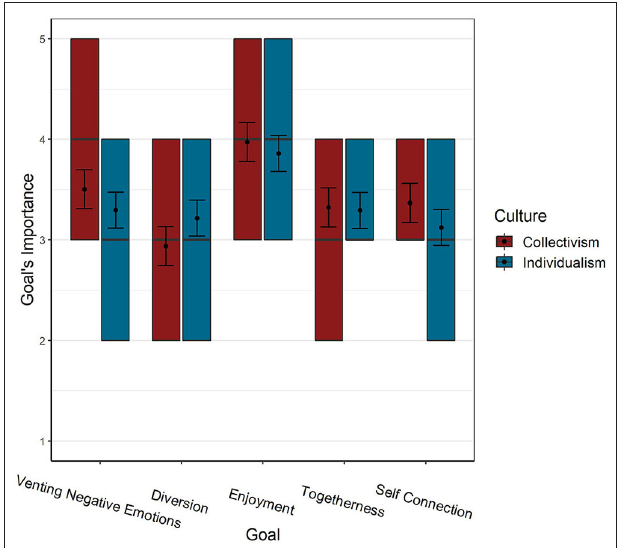
FIGURE 1 | Importance of goals as a function of culture. Error bars represent 95% CI. Colored squares represent the 2nd and 3rd quartiles of responses. Black lines represent the median, and dots represent the